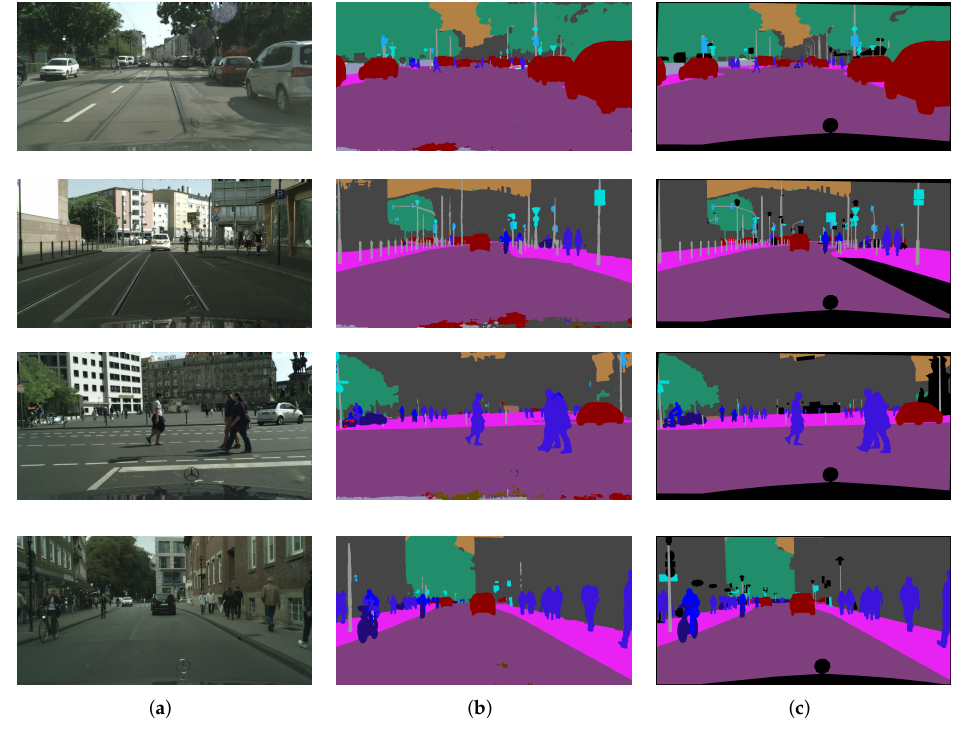
Figure 4. Semantic segmentation results on the Cityscapes. ( a ) Original images. ( b ) EDBNet. ( c ) Ground